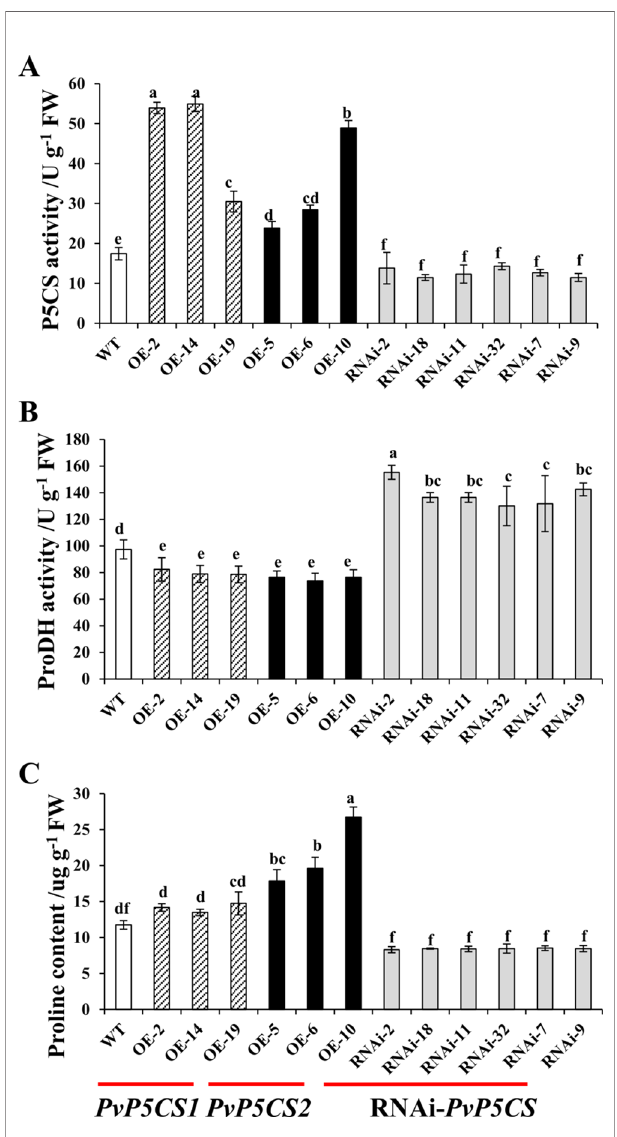
FIGURE 2 | P5CS, ProDH activity and proline content in PvP5CS OE and RNAi transgenic plants. P5CS (A) and ProDH (B) activity and Proline content (C) in PvP5CS OE and RNAi transgenic plants. Data are mean values of three biological repeat, and signi fi cance of treatments was tested at the P < 0.05 level (one way ANOVA, Dunnett's